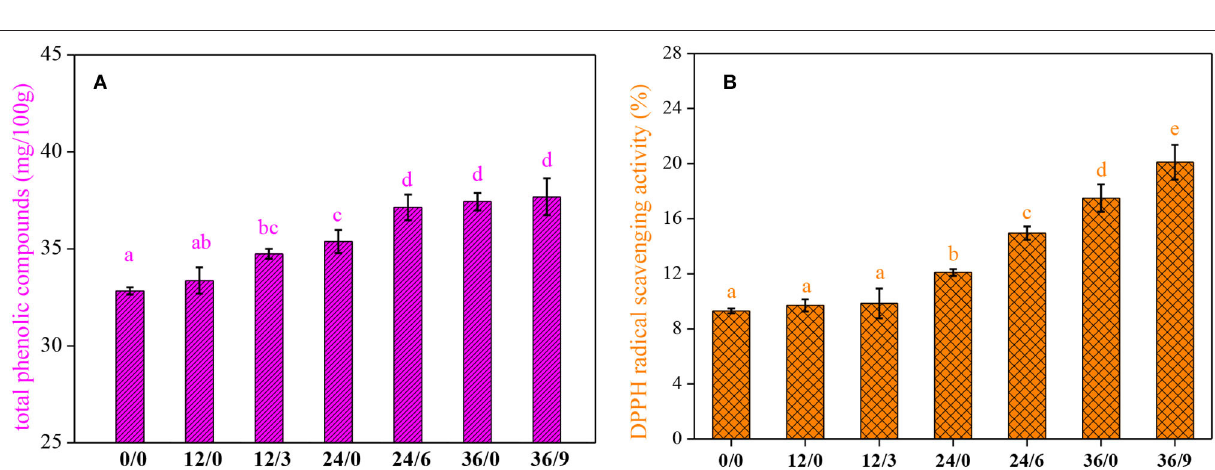
FIGURE 4 | The ascorbic acid contents of whole wheat flour during germination under UV-B radiation. Different letters indicate the results of Duncan’s multiple range test at 5% level of significant difference among different germination and UV-B radiation time, respectively.